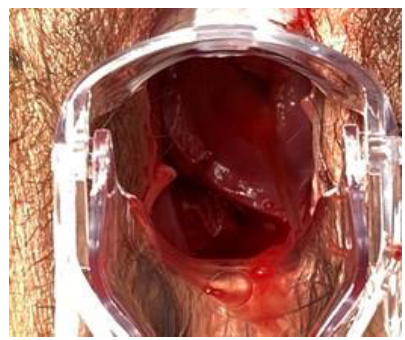
Figure 1. Evidence of vaginal perforation.